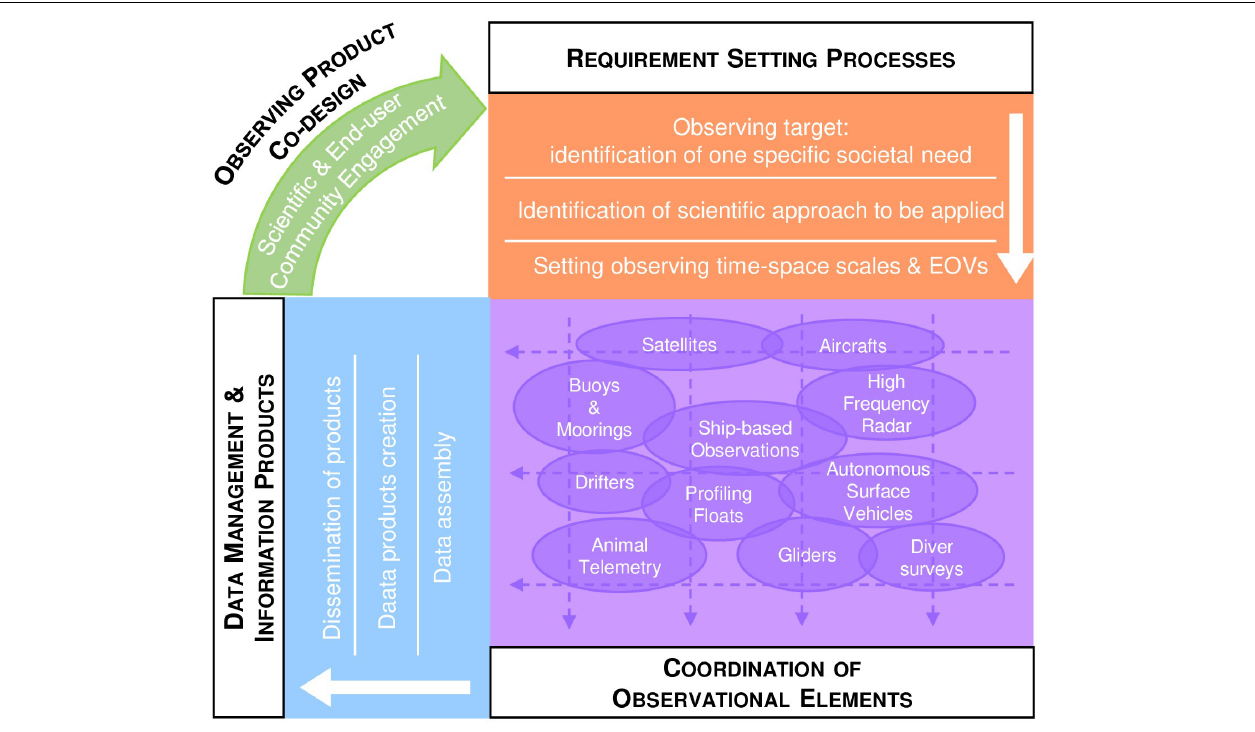
FIGURE 1 | Conceptual structure for an ocean observing value chain designed to match the original structure of the Framework for Ocean Observing (FOO) (Adapted from the FOO, 2012).